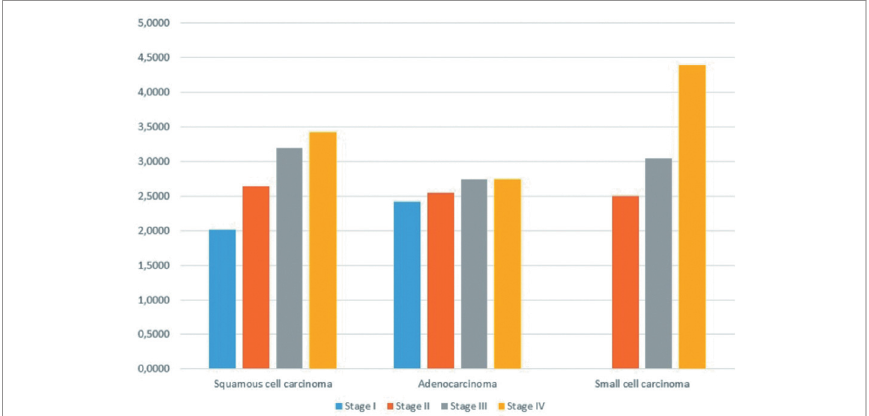
Figure 1. Mean lead (Pb) concentrations detected in the di ff erent histological subtypes of lung cancer according to stage